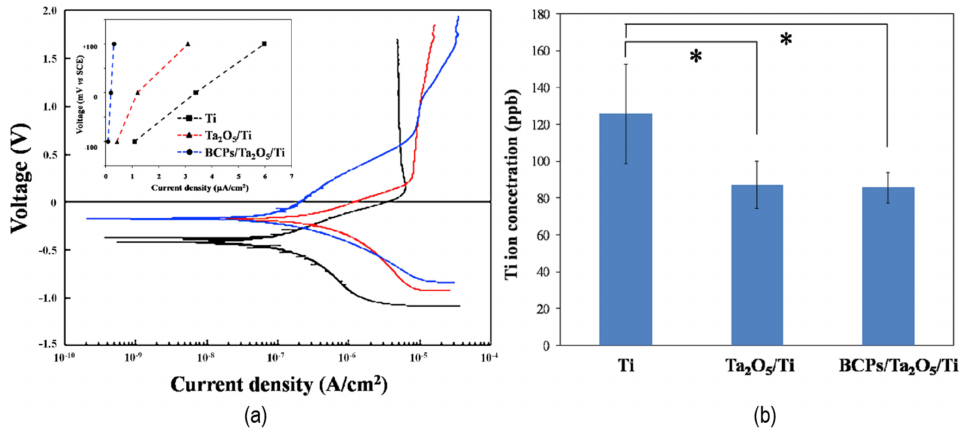
Figure 4. Corrosion behavior of Ti, Ta 2 O 5, and BCPs/Ta 2 O 5 /Ti samples ( a ) Corrosion current density ( b ) ion concentration. (* indicates statistical significance p < 0.05). Reprinted with permission from [92].